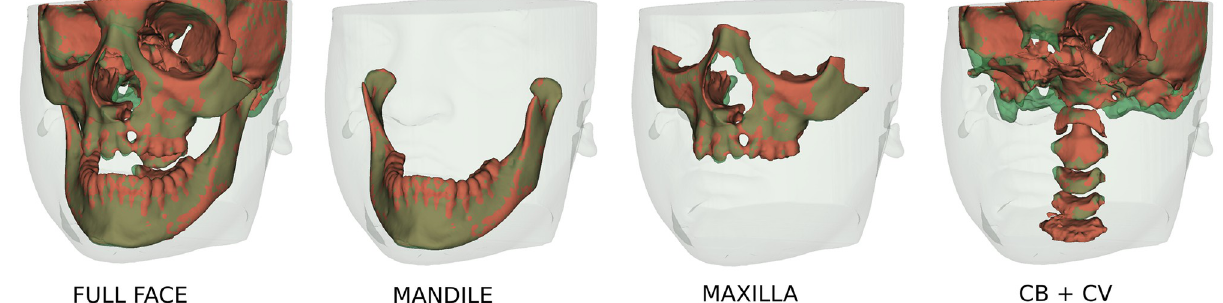
Fig 5. Visualization of the automatic full-face segmentation results. In red, the prediction is superposed with the manual segmentation in transparent green. On the full-face, we can see that the models managed to average the separation line between the maxilla and the mandible. The separation on the manual segmentation is different. It also explains why the metrics are lower than the mandible for those two skull structures.